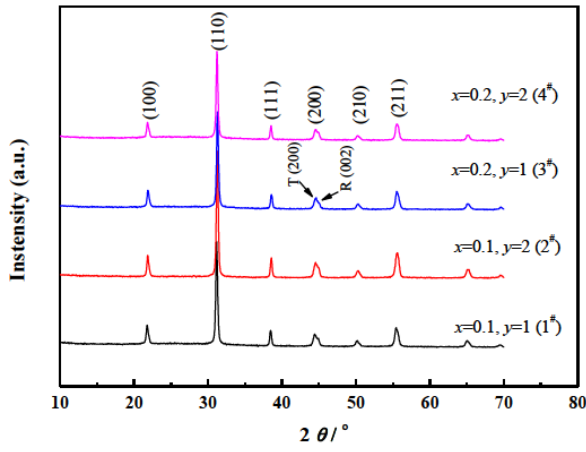
Figure 1: X-ray diffraction patterns of PNN-PZT + x wt.% CuO + ywt.% LiBiO 2 + 1wt.% Pb 3 O 4 ceramics with different amounts of CuO, Li 2 CO 3 and Bi 2 O 3